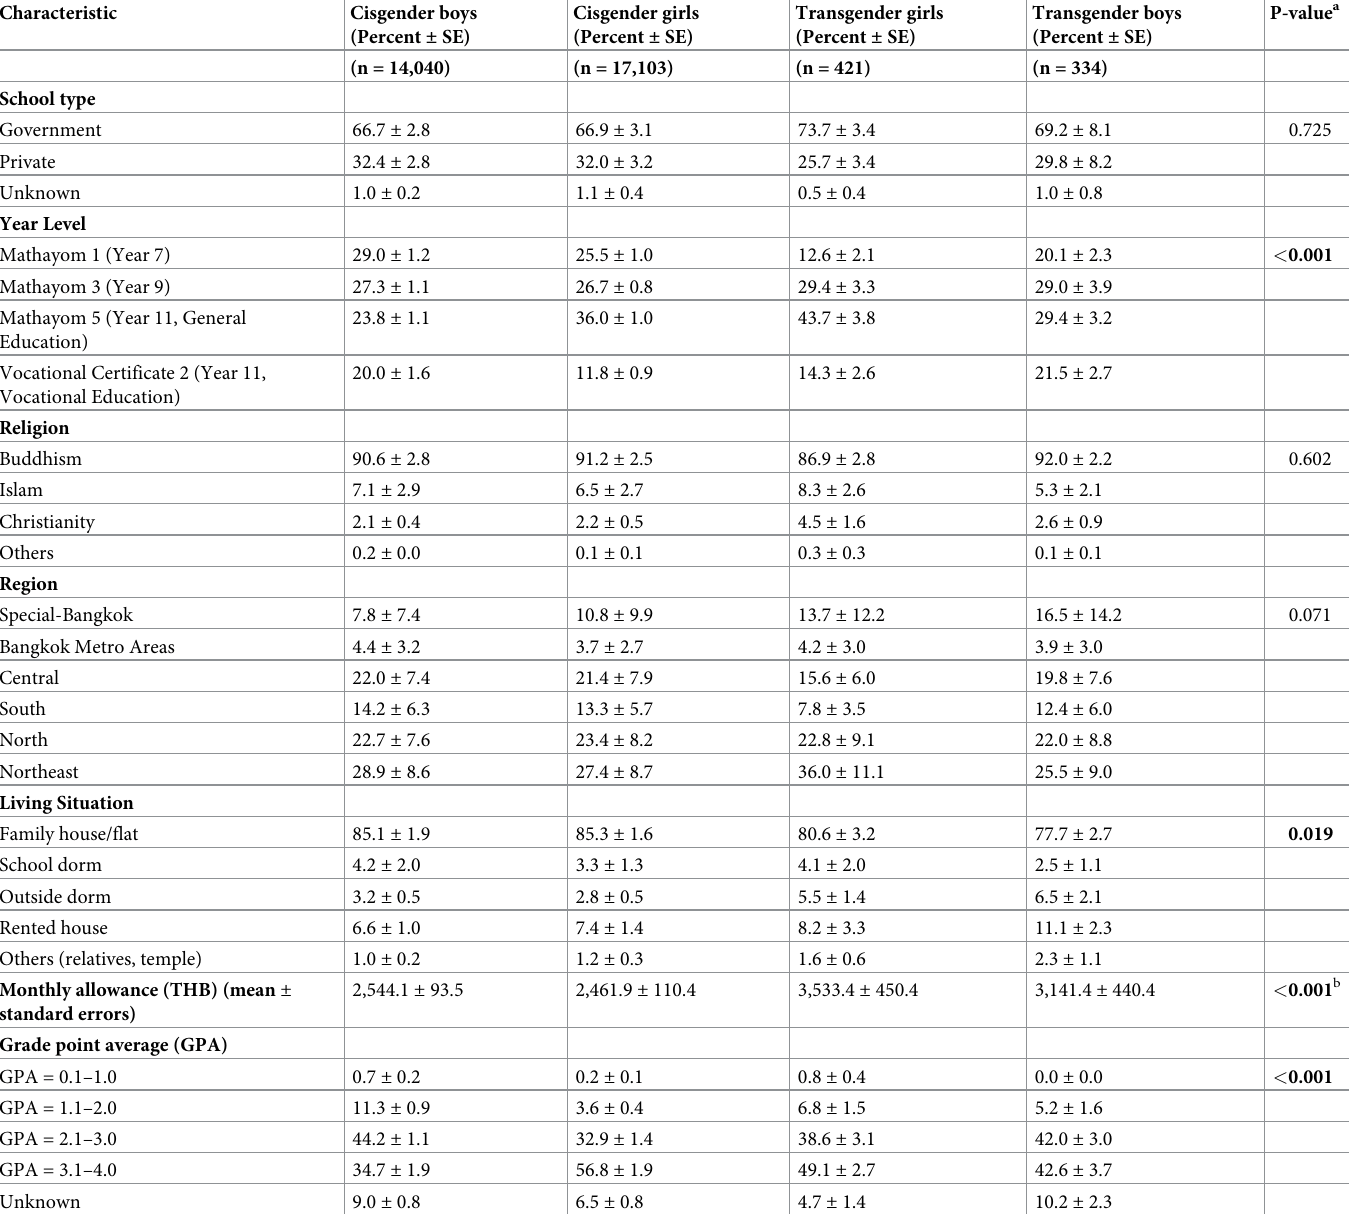
Table 2. Characteristics of study respondents, weighted percent ± SE unless otherwise noted (n = 31,898 respondents).